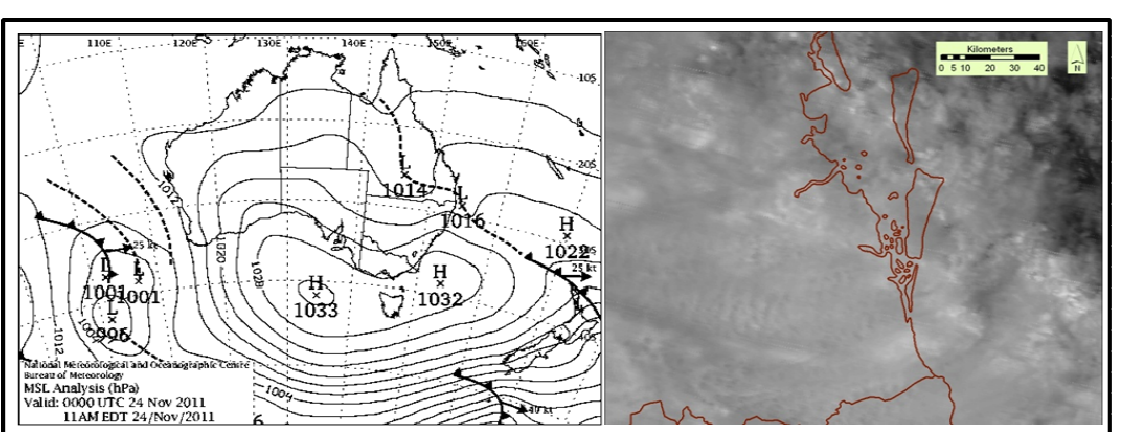
Figure 4. MSLP chart for 00:00 UTC 24 November 2011 and MODIS band 1 image 23:15 UTC 23 November